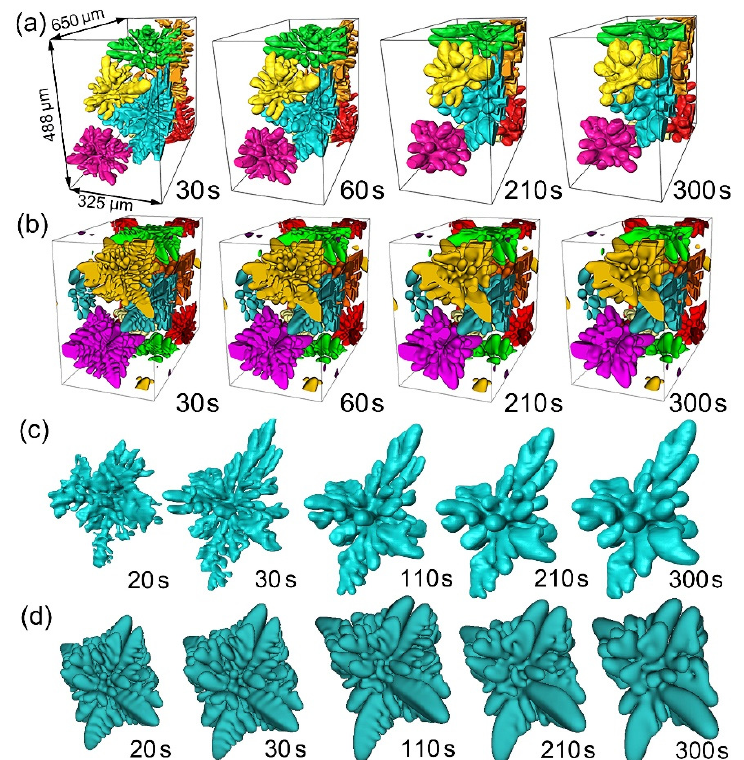
Figure 7. ( a ) Multi-dendrite (those from V2 of Figure 2e) growth and coarsening at the solidification times of 30, 60, 210, and 300 s and ( b ) the corresponding phase field simulated ones. ( c ) A single turquoise-colored dendrite selected from Figure 7a, and ( d ) the corresponding phase field simulation.